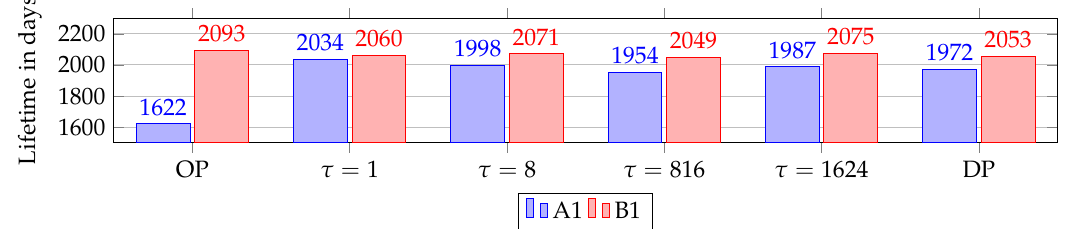
Figure 14. Funneling effect at A1 and B1. Represented with node lifetime in days. (Note: y-axis starts at 1500 days).